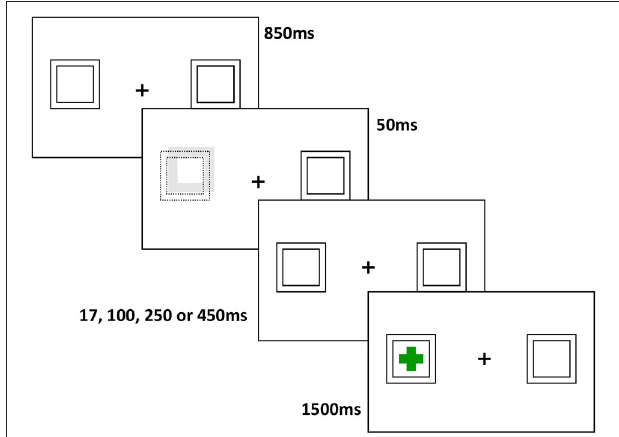
FIGURE 1 | Schematic diagram of a valid trial: Following a fixation period of 850ms, a cue is presented for 50ms (displacement and increased luminance of one of the two peripheral boxes), followed at various intervals by a target cross in either the same, or opposite hemifield. The target remains on screen for 1,500ms, and subjects are asked to generate a saccade to the target as quickly as